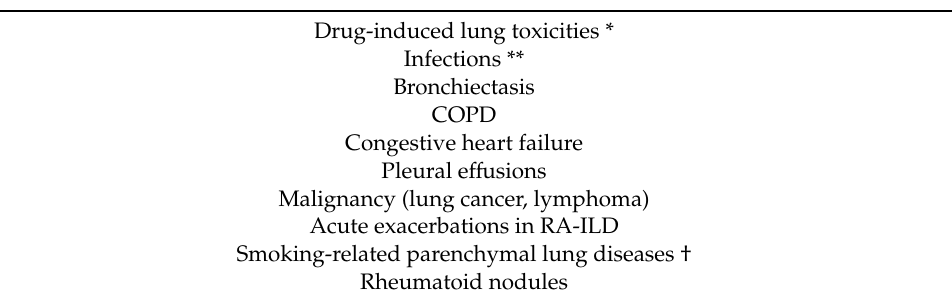
Table 3. Di ff erential diagnosis of